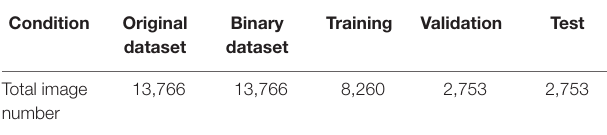
TABLE 2 | The number of image datasets used for the DL analysis.